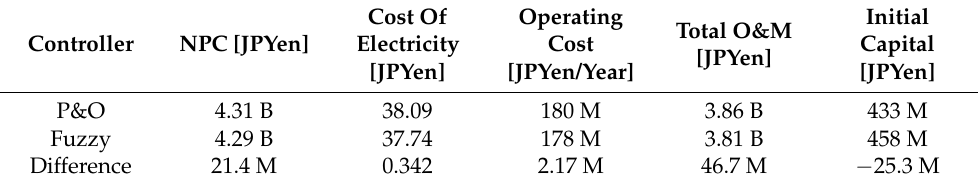
Table 11. Cost analysis comparison of the FLC-based and P&O-based MPPTs.